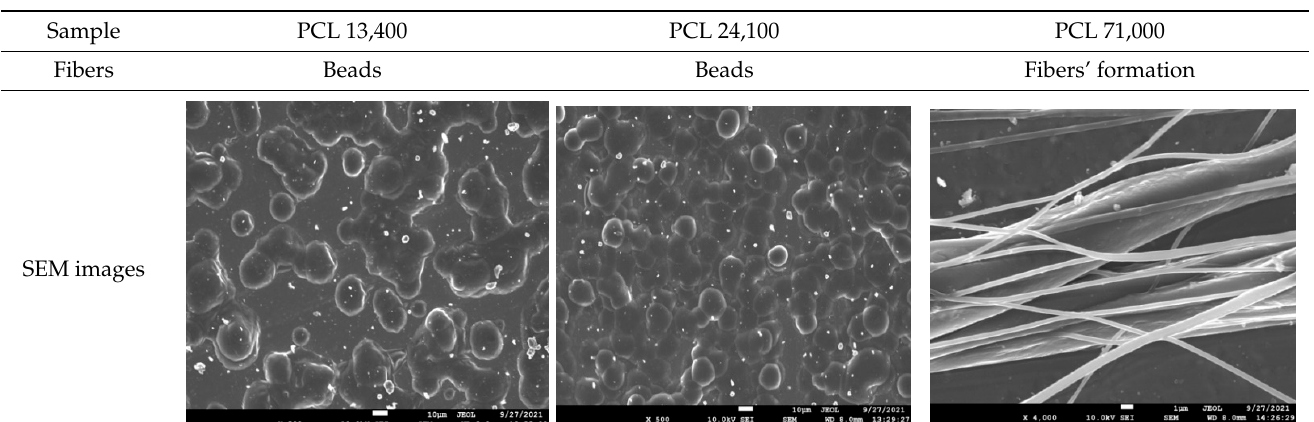
Table 3. SEM micrographs depicting the effect of the molecular weight of polymer on the formation of nanofibrous structures.